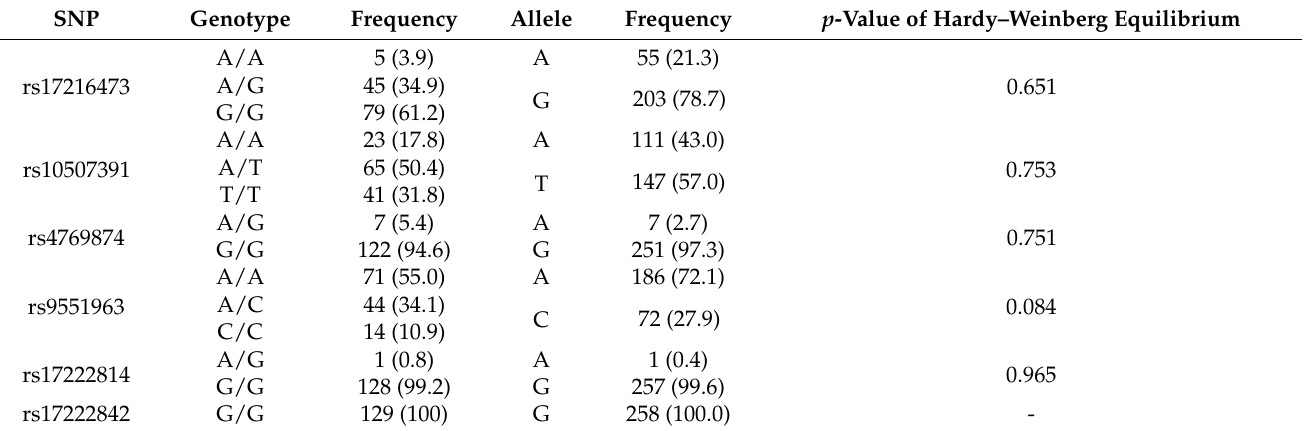
Table 3. Genotype with allele frequencies of ALOX5AP gene polymorphisms.